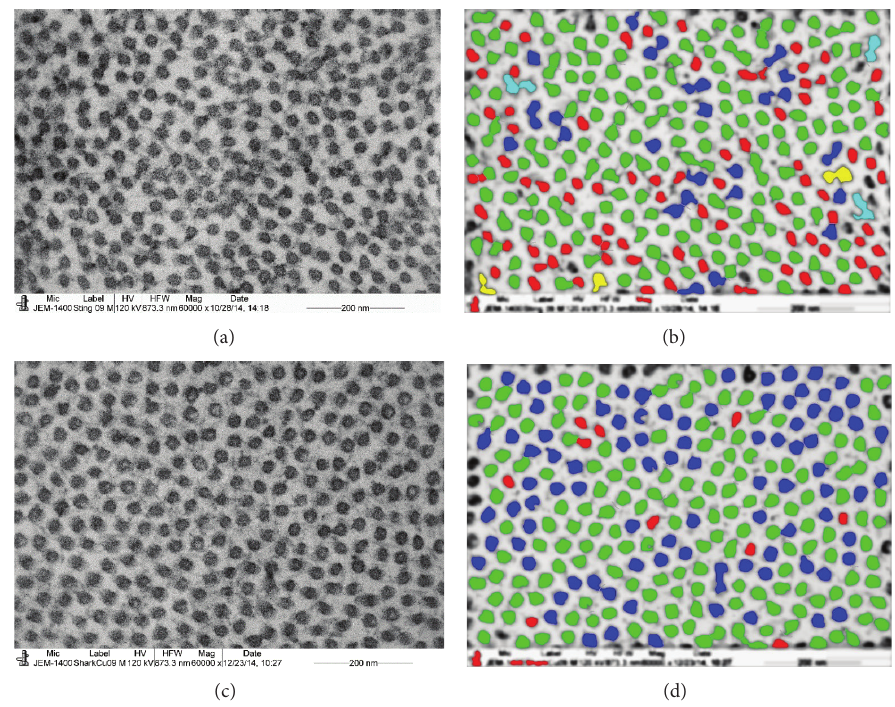
Figure 5: Electron micrograph and colour coded digital images of CF of the middle stroma of stingray and shark; (a) electron micrograph of middle stroma of stingray; (b) colour coded digital image of (a); (c) electron micrograph of middle stroma of stingray; (d) colour coded digital image of (c). Please note that, in stingray, most of the CFs were in the range from 15 to 25 nm (red and green) and few of them were in the range from 25 to 30 nm (blue). In shark very few CFs were in the range from 15 to 20 nm, and most of the CFs were in the range from 20 to 30 nm (green and blue). Blue: 25–30 nm; yellow: 30–35 nm; terracotta: 35–40 nm; pink: 40–45